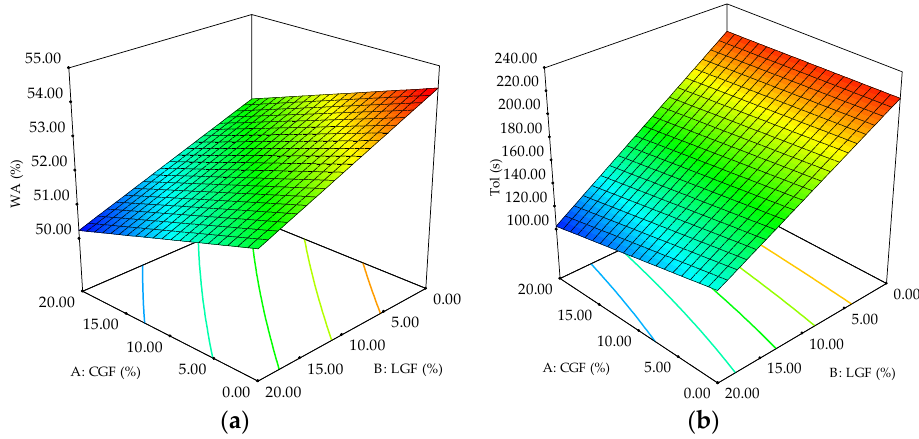
Figure 2. Response surface plot of ( a ) water absorption (WA) and ( b ) dough tolerance to kneading (Tol) as a function of chickpea germinated flour (CGF) and lupin germinated flour (LGF) addition. The variations of dough consistency with CGF and LGF levels are presented in Figure 3. Since the model for D450 is first-order, the fitted response surface is a plane. The CGF factor did not affect significantly dough consistency after 250 and 450 s respectively ( p > 0.05), while LGF addition led to the decrease of these parameters as the level raised (Figure 3). LGF showed significant influence ( p < 0.05) on dough consistency parameters (Table 2), while the interaction between factors affected in a significant way only the consistency after 250 s.